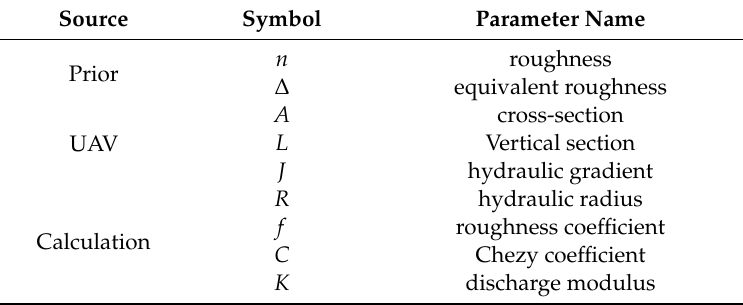
Table 3. Parameter classification and acquisition